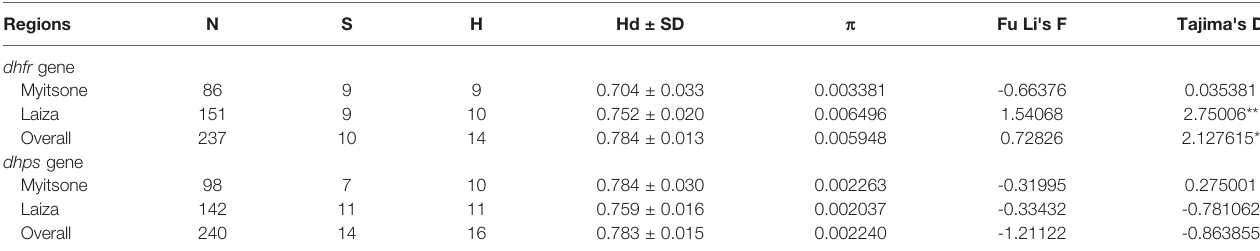
TABLE 1 | Genetic diversity and tests of neutrality of the pvdhps and pvdhfr genes in P. vivax samples from the China/Myanmar border. Regions